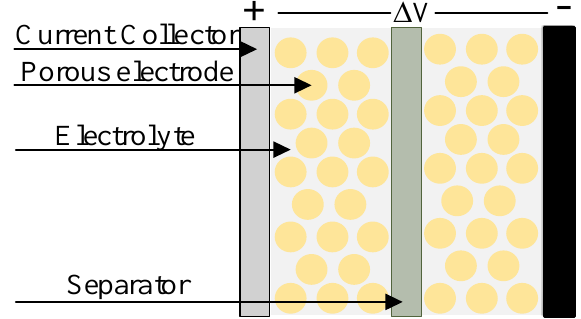
Figure 5. Individual Ultra-capacitor